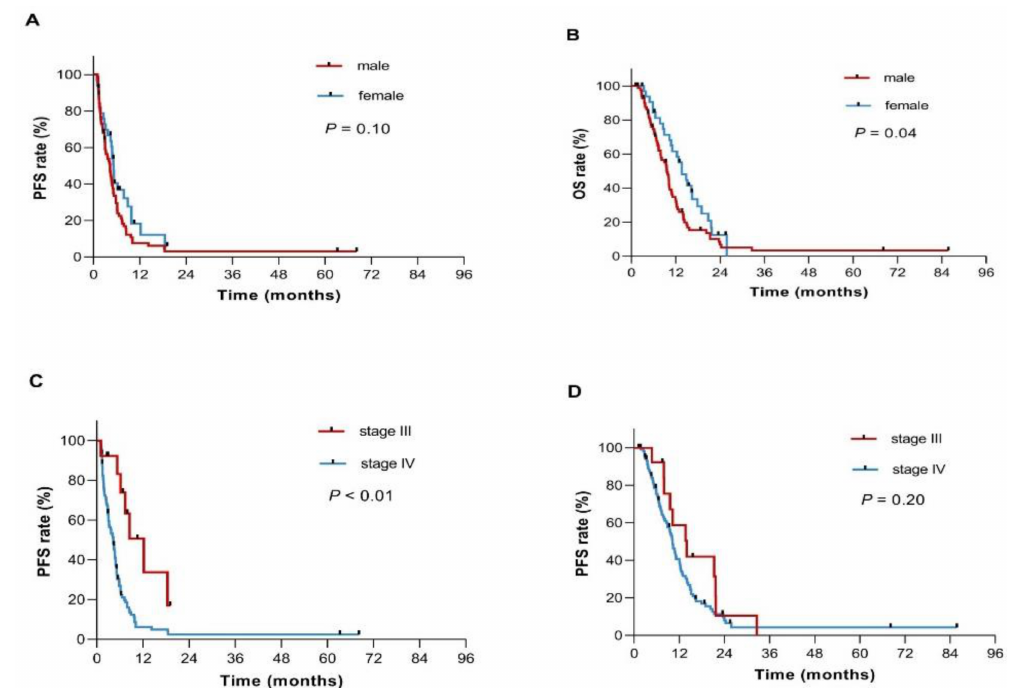
Figure 2. Progression-free survival (PFS) and Overall survival (OS) for patients with unresectable pancreatic cancer in the subgroups. ( A , B ) Kaplan-Meier plots of PFS and OS according to gender; ( C , D ) Kaplan-Meier plots of PFS and OS according to clinical stage.